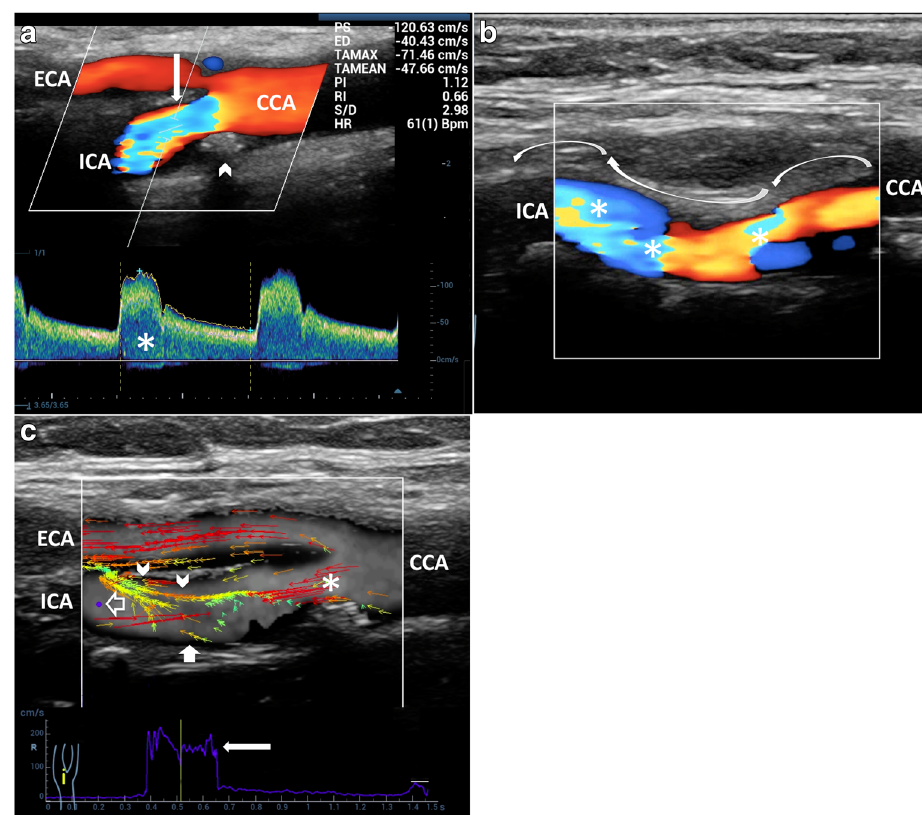
Fig. 11 Flow patterns in moderate stenosis. a ) B-mode and CD of the CB show an eccentric plaque ( arrowhead ; 50% – 60% diameter stenosis) and increased velocities ( white arrow ). PW depicts an increased velocity (PSV 120 cm/s) and spectral broadening (*). b) Distally to the stenosis ( arrow ), CD shows a mixture of colors (*) due to aliasing and to the non-linear vessel course ( curved arrows ). c ) VFI during systole: high-velocity vectors (*) at the stenosis; orange/ yellow medium velocity vectors ( arrowheads ) and complex flow below: low-velocity green vectors and reverse flow red vectors ( white short arrow ). Turbulence duration ( arrow ). CCA = Common carotid